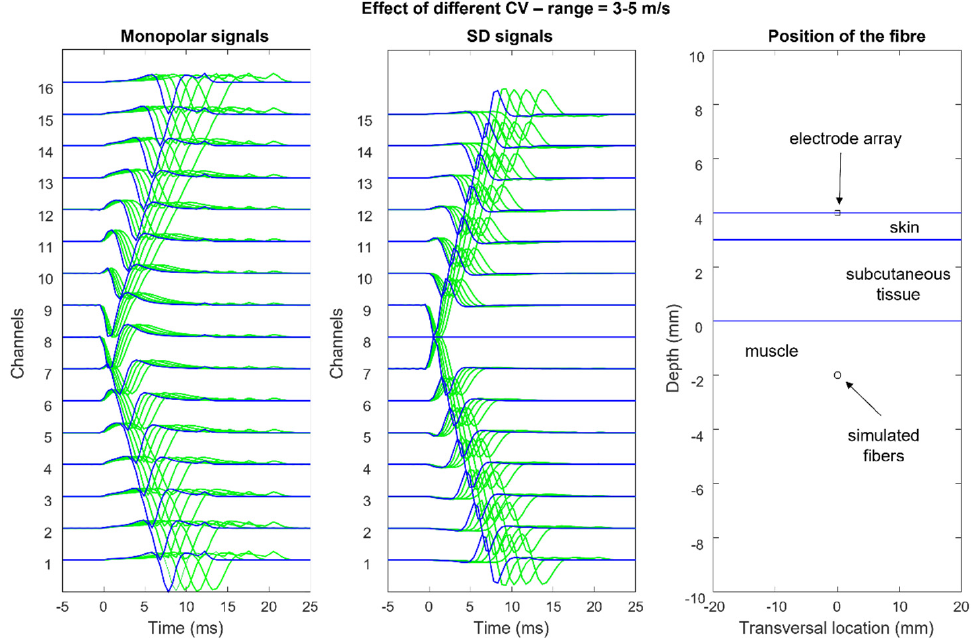
Figure 15. Effects of changing muscle fiber conduction velocity (CV). Observe that the width of the action potential and the end-of-fiber effect become narrower and the slope of the pattern increases as the CV increases. The observed changes affect both the single sEMG channels and the array of signals. When a single channel is recorded, the effects are not detectable. (See animation in Supplementary Materials, Sup9). Reproduced from https://www.robertomerletti.it/en/emg/material/teaching/module9.